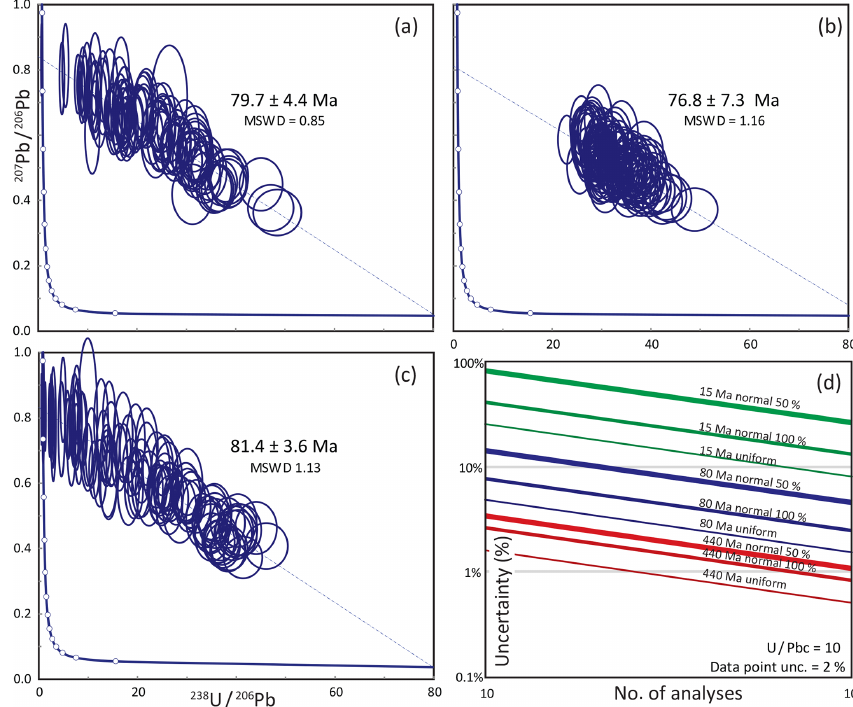
Figure 5. Panels (a) – (c) show an example of the differing randomly generated distributions of 100 analyses with the same maximum U / Pb c . Panel (a) shows a normal distribution for the entire range of U / Pb c ; (b) is a normal distribution over the upper 50% of the same range. The uniform distribution, shown in (c) , yields the lowest uncertainties because there are more analyses at both the upper and lower intercepts. Panel (d) shows how the percent uncertainty decreases with number of analyses, depending on the type of 238 U / 206 Pb distribution depicted in (a) – (c) ; data in (d) assumed the best case scenario of 2% uncertainty per data point and a U / Pb c ratio of 10 for samples of 440, 80, and 15Ma. Best uncertainties are achieved with uniform distributions and maximum spread. Although percent uncertainties are always better for older samples, younger samples yield better absolute uncertainties for well-distributed